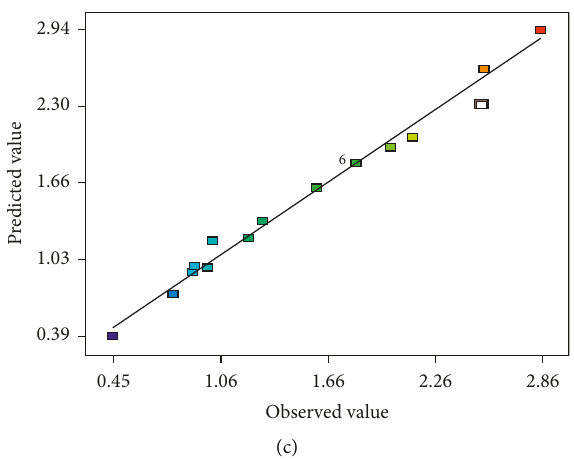
Figure 8: (a) Response surfaces for dye concentration in the surfactant-rich phase. (b) Pareto chart for dye concentration in the surfactant- rich phase. (c) Relationship between predicted values of dye concentration in the surfactant-rich phase and the observed value. Table 4: Regression